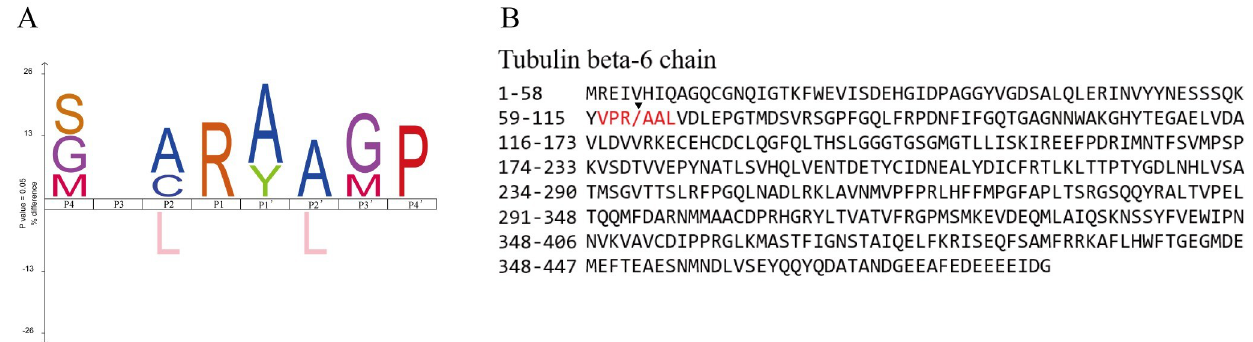
Fig 7. Cleavage specificities of SjCB2. (A) The cleavage sites for SjCB2 are represented as iceLogos. (B) Protein sequence of tubulin beta-6 chain, the cleavage site is pointed by inserted triangle.